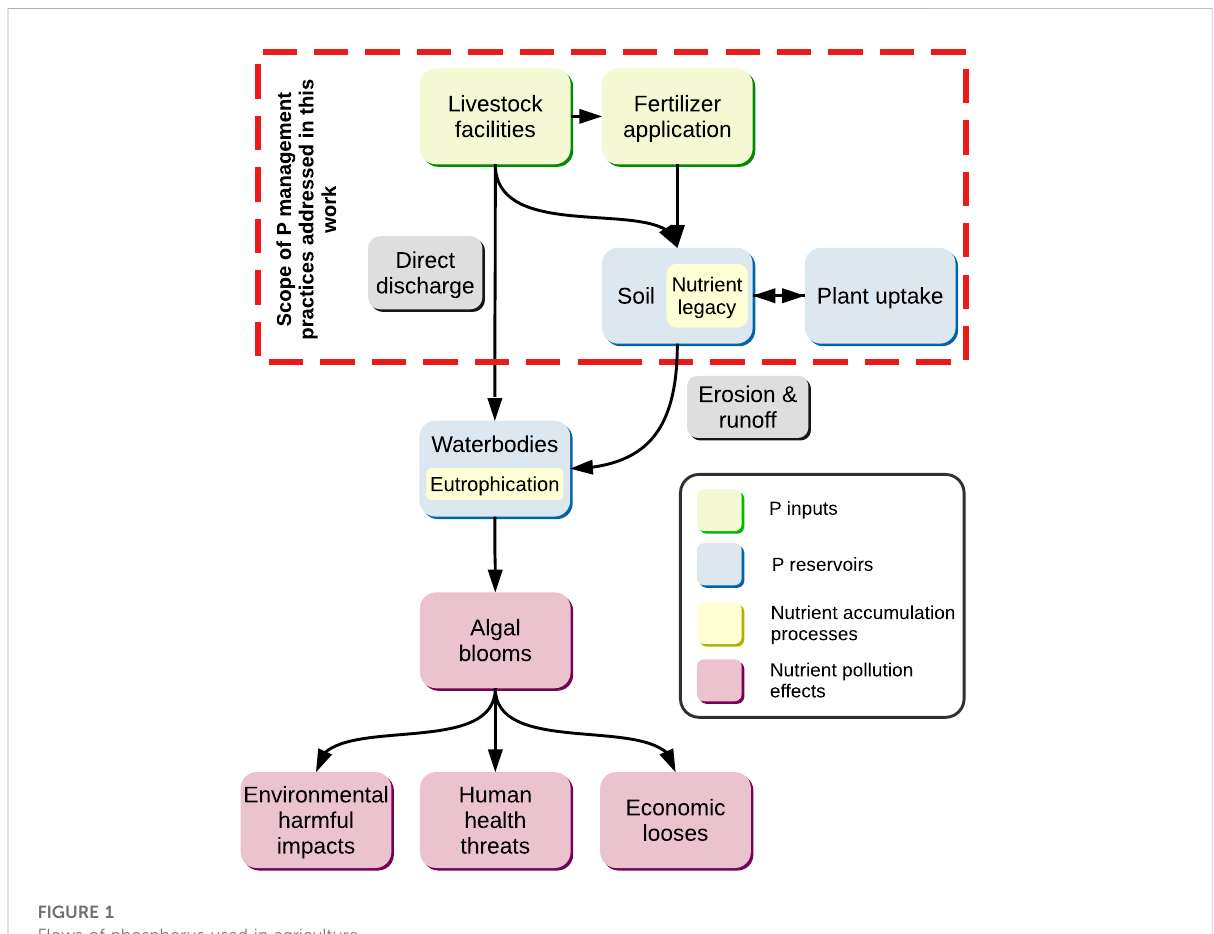
FIGURE 1 Flows of phosphorus used in